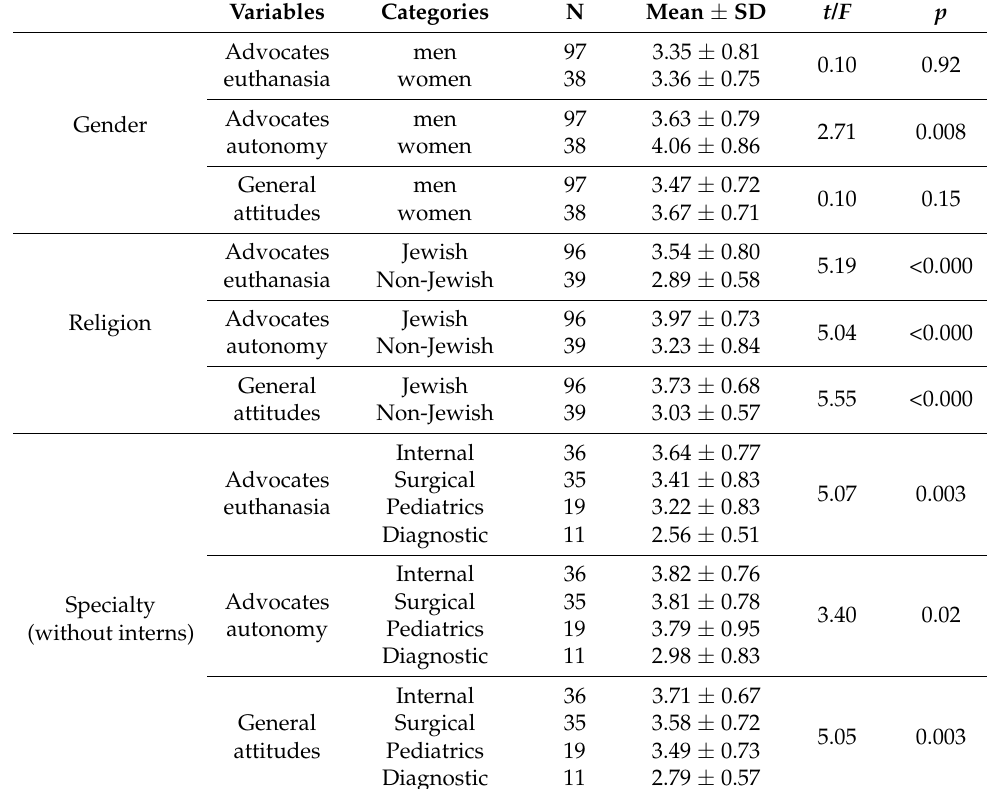
Table 4. Differences between Gender, Religion, and Specialty Regarding Attitudes towards